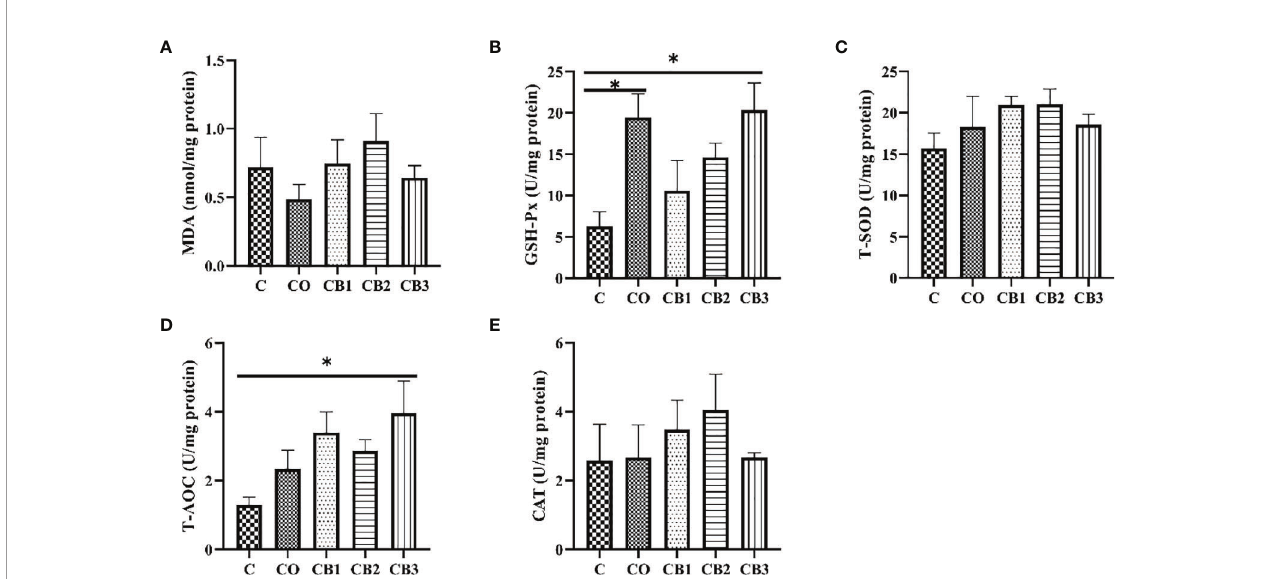
FIGURE 5 | Effects of dietary chitosan oligosaccharides (COS) and Clostridium butyricum synbiotic supplementation on the antioxidant status of jejunum mucosa in early-weaned pigeon squabs. (A) MDA, malondialdehyde. (B) GSH-Px, glutathione peroxidase. (C) T-SOD, total superoxide dismutase. (D) T-AOC, total antioxidant capacity. (E) CAT, catalase. Values are means with the SEM of eight squabs. * p < 0. 05 . C group, control group, squabs fed with arti fi cial crop milk; CO group, squabs fed with arti fi cial crop milk + 150 mg/kg COS; CB1, CB2, and CB3 group, squabs fed with arti fi cial crop milk + 150 mg/kg COS + 200, 300, and 400 mg/kg C. butyricum , respectively.